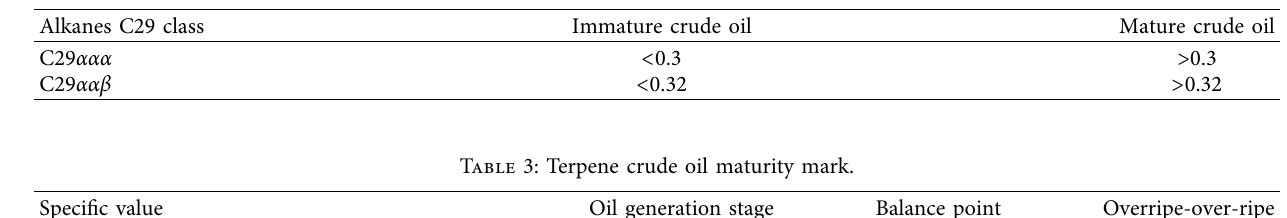
Table 2: C29 mature marks of sterane crude oil.